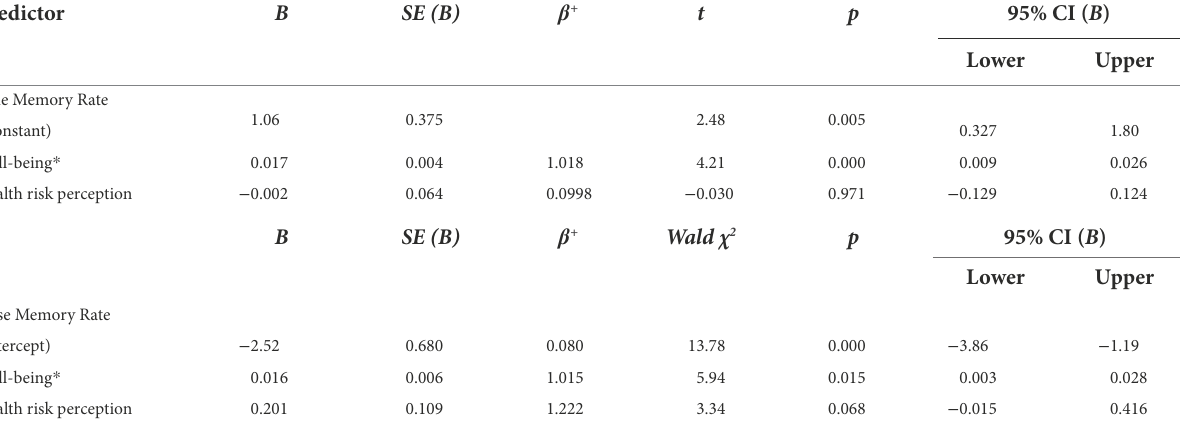
TABLE 2 Regression coefficients for predictors of vulnerability to COVID-19 news (Experiment 1).